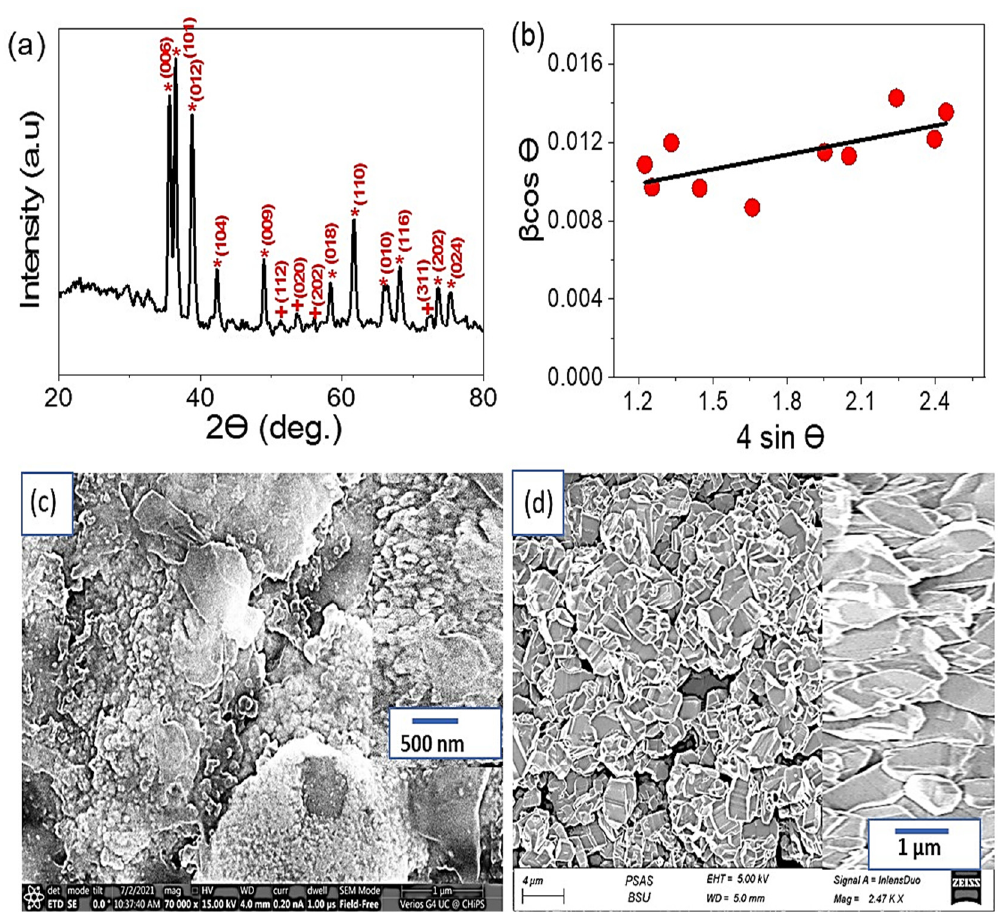
Figure 1. ( a ) XRD patterns and ( b ) W–H plots of CuFeO 2 . ( c ) SEM of CuO and ( d ) CuFeO 2 nano-